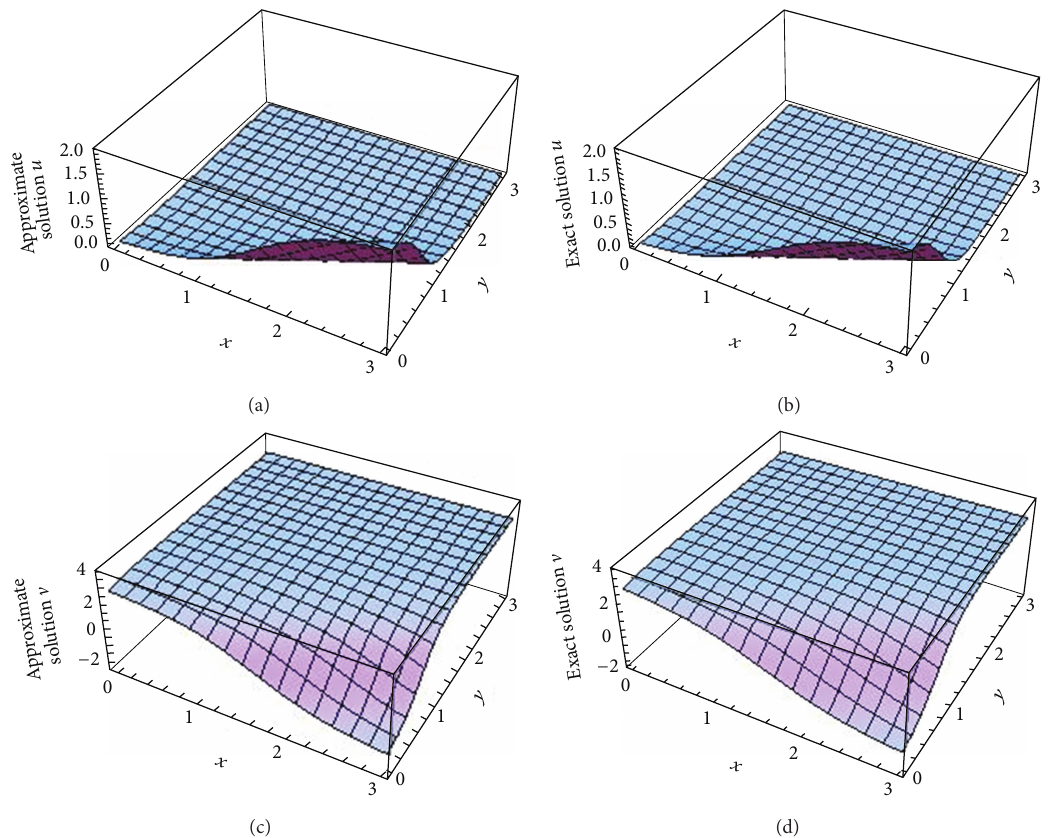
Figure 1: The surfaces show (a) the numerical approximate solution of 𝑢(𝑥,𝑦,0.3) , (b) the exact solution of 𝑢(𝑥,𝑦, 0.3) , (c) the numerical approximate solution of V (𝑥,𝑦,0.3) , and (d) the exact solution of V (𝑥, 𝑦,0.3) when 𝛼 = 1 and 𝛽 = 1